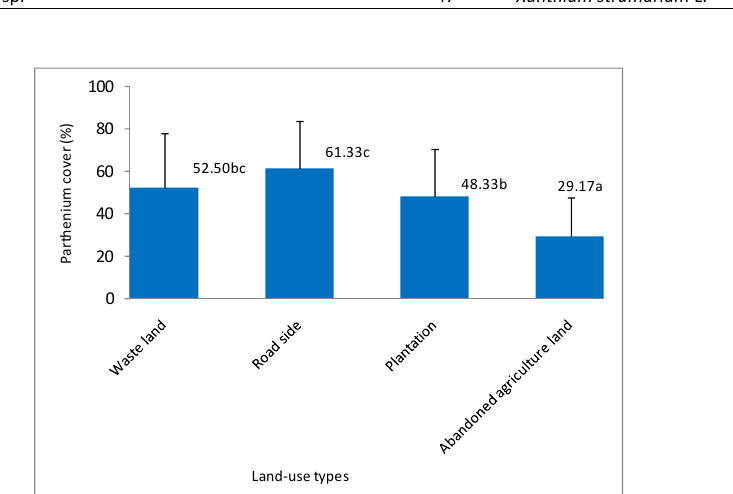
Fig. 5: Parthenium cover in different land ‐ use types. The mean values were compared by ANOVA (F 3, 116 =11.11; P<0.001) followed by Duncan homogeneity test. The values with same alphabet in superscript are not significantly different at P=0.05